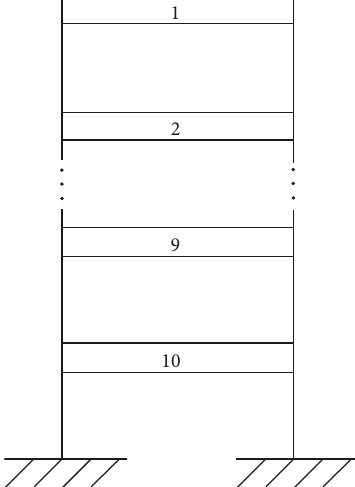
Figure 1: A ten-storey shear frame